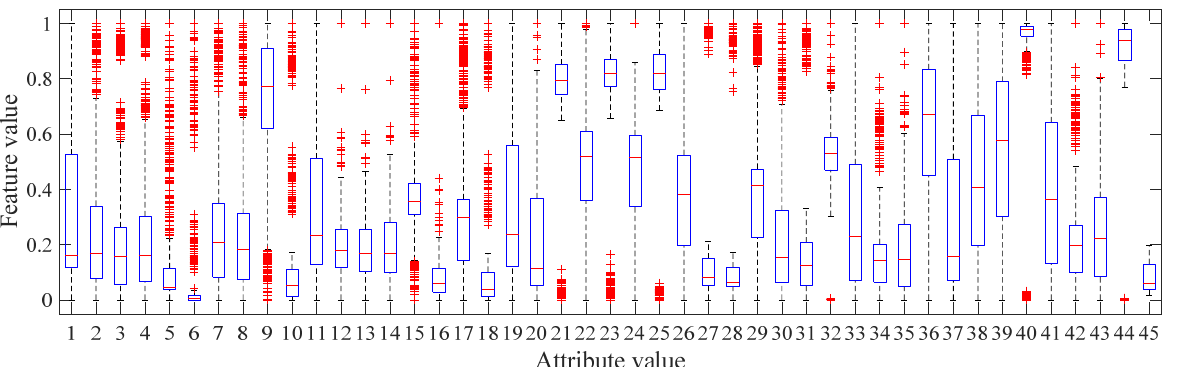
Figure 4. Multi − domain characteristic box plot of bearing in ten states. Figure 4. Multi-domain characteristic box plot of bearing in ten